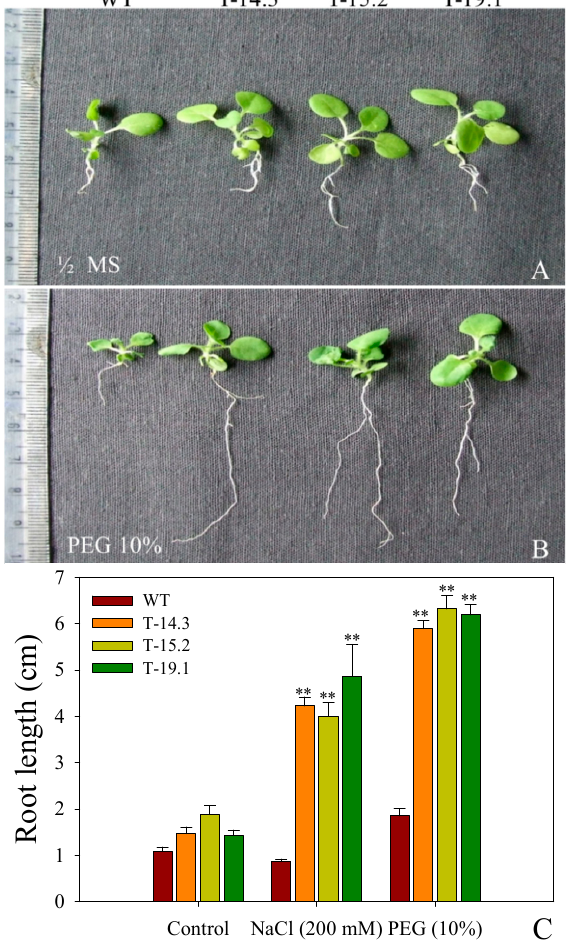
Figure 16. Seedling growth under salt and dehydration stress. ( A , B ) Seedlings of WT and AnnAt8 overexpressing transgenic tobacco plants after five weeks of growth on half strength MS and 10% polyethylene glycol PEG; ( C ) Root lengths of WT and AnnAt8 transgenic seedlings after five weeks of growth on half strength MS, 200 mM NaCl and 10% PEG, respectively, for each biological replicate (n) 15 seedlings of WT and transgenic lines were taken. Data represent means of n = 3 ± SE. Two asterisks indicate that the mean values of transgenic lines were significantly higher than that of WT (control) when analyzed by one-way ANOVA ( p < 0.01).